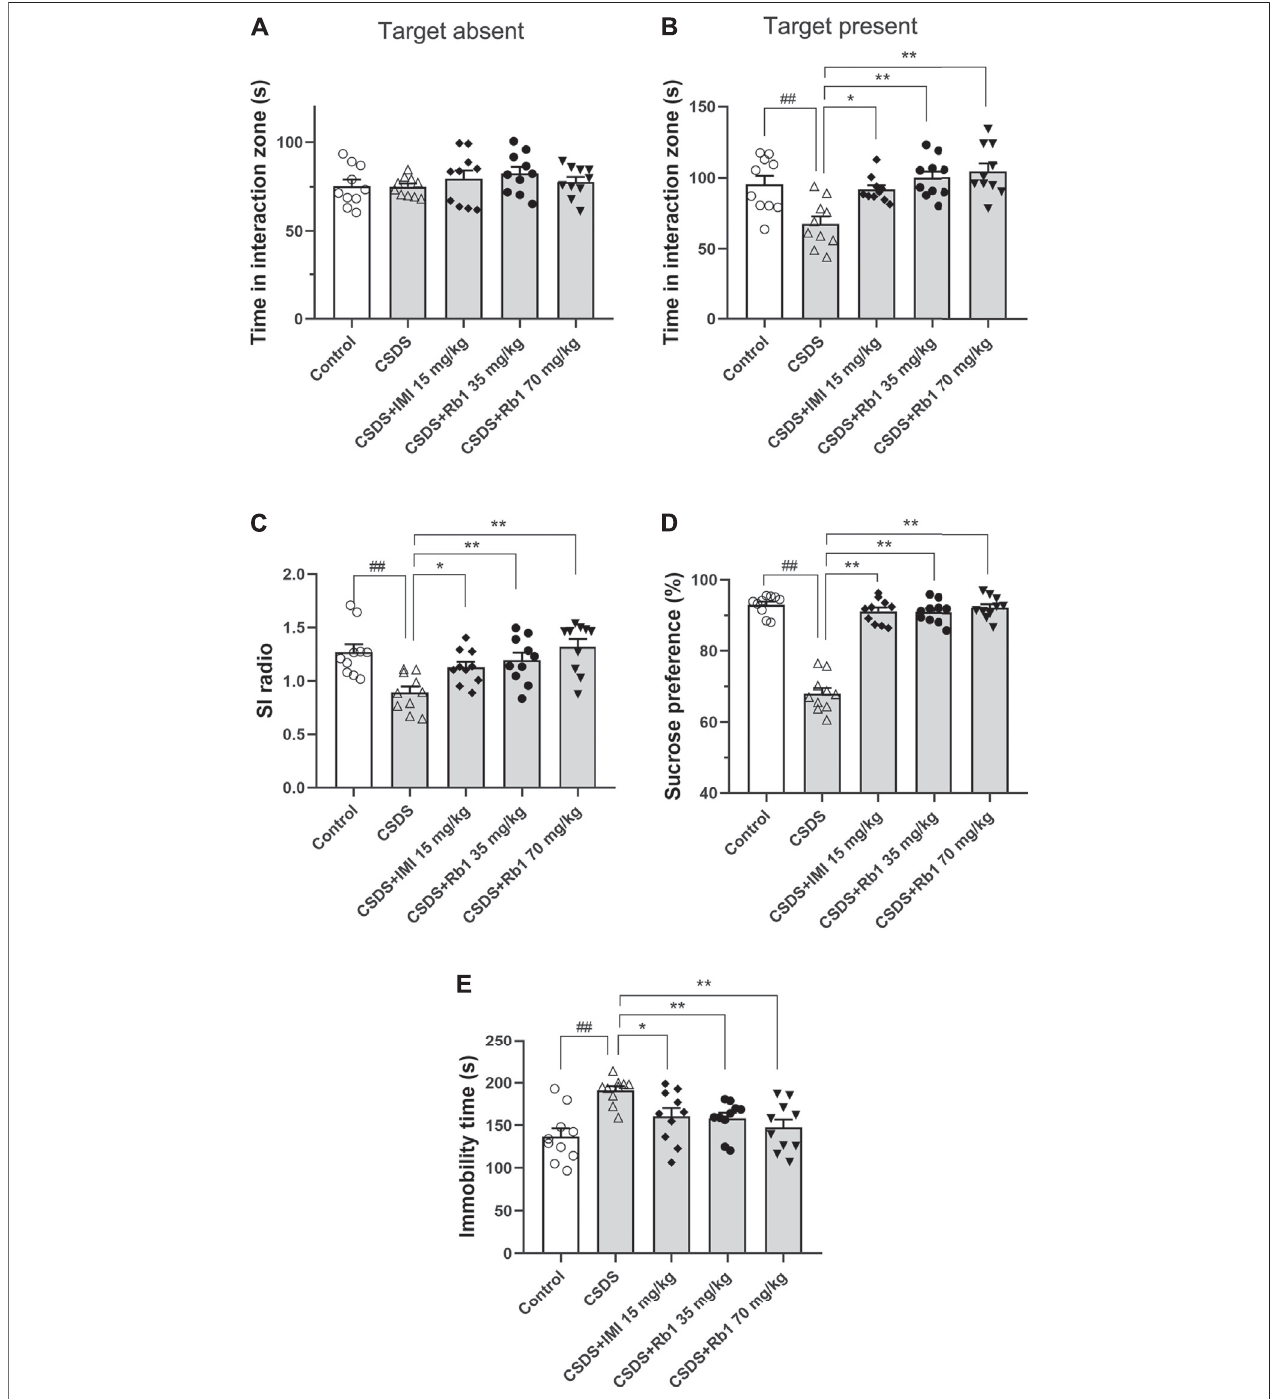
FIGURE 2 | Rb1 exerted antidepressant-like effects in a CSDS-induced depression model (A – C) The time spent in the social IZ and the SI ratio in the SIT. (D) The intakeofsucrose(inpercentage)intheSPT. (E) ImmobilitytimeintheFST.N (cid:2) 10ineachgroup;thedataarepresented asthemean ± S.E.M. ## p < 0.01,vs.thecontrol group; * p < 0.05, ** p < 0.01, vs. the group exposed to CSDS; one-way ANOVA.